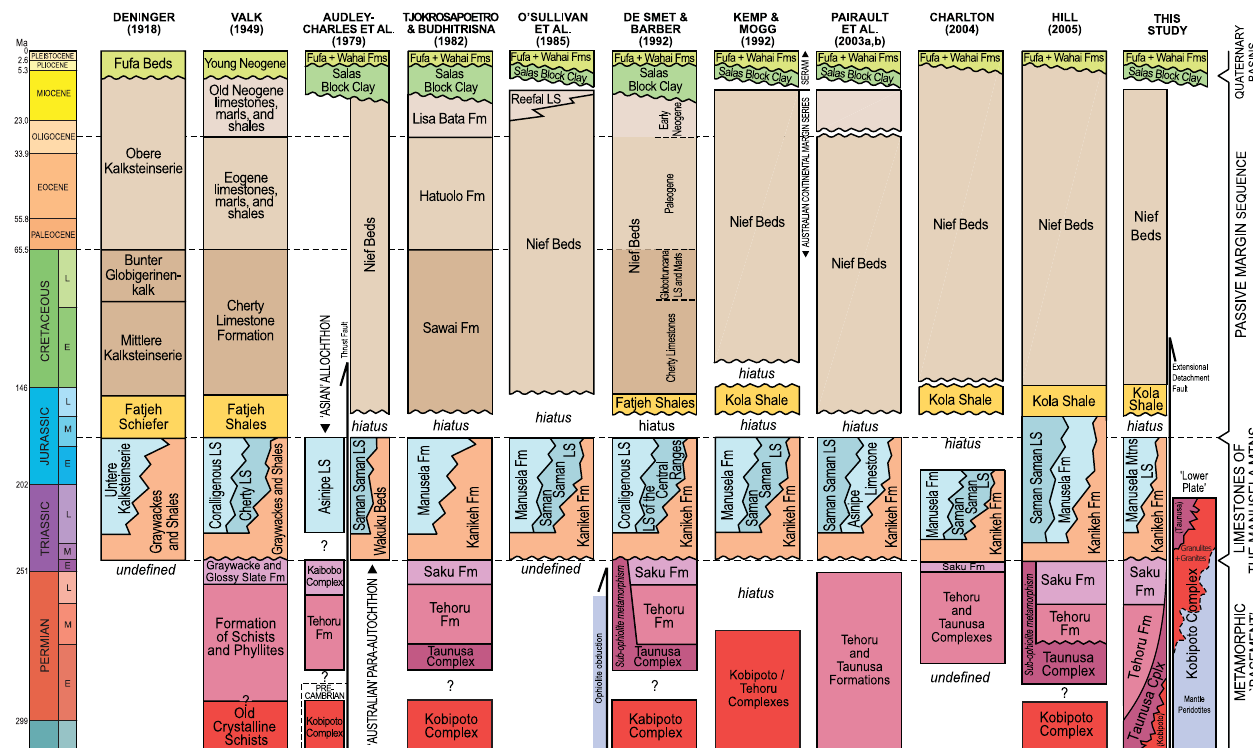
Fig. 4. Comparison of the ten main previous chronostratigraphical proposals for Seram, arranged in chronological order to show the pro- gression of ideas (redrawn from Deninger, 1918; Valk, 1945; Audley-Charles et al., 1979; Tjokrosapoetro and Budhitrisna, 1982; O’Sullivan et al., 1985; de Smet and Barber, 1992; Kemp and Mogg, 1992; Pairault et al., 2003a, b; Charlton, 2004; Hill, 2005). Equivalent (and approx- imately equivalent) units are displayed in the same colours to allow easy correlation. Note that the stratigraphic position of the metamorphic units relates to the protolith age and not the age of metamorphism. Our reinterpretation is presented in the rightmost column. Columns for Deninger (1918), Valk (1945), Audley-Charles et al. (1979), and Tjokrosapoetro and Budhitrisna (1982) are redrawn based largely on the in- terpretation given by de Smet and Barber (1992). Some stratigraphic boundaries are approximate due to lack of information in the literature. “LS” = Limestone(s); “Fm(s)” = Formation(s); “Mtns” = Mountains. Geological timescale adapted from Walker and Geissman